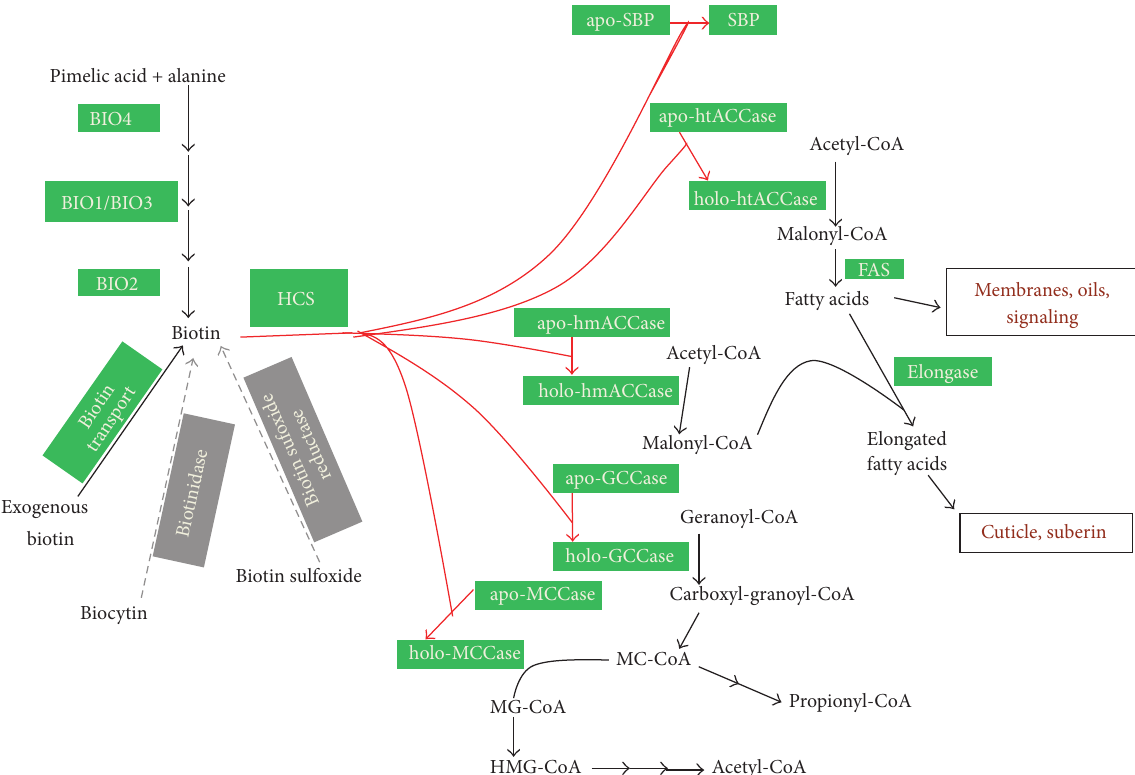
Figure 1: Biotin network in plants. Schematic map of the metabolism associated with biotin. Metabolites’ names are in black text. Red arrows represent the biotinylating actions of HCS on biotin-dependent proteins. Black arrows represent other metabolic reactions characterized in plants. Enzymes identified by direct biochemical evidences are shaded in green boxes. Grey-dotted arrows represent the reactions characterized in humans or E. coli but not in plants so far. Enzymes not identified in plants but characterized in humans or E. coli are shaded in grey